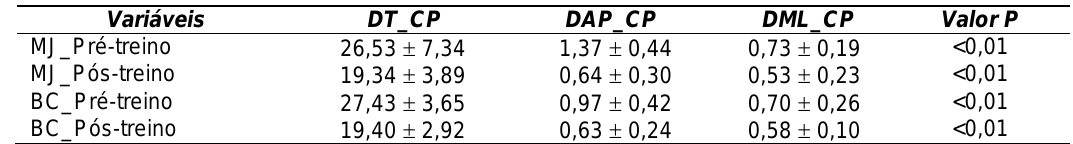
Tabela 2. Médias e desvios padrão das variáveis relacionadas ao controle de tronco nas duas condições